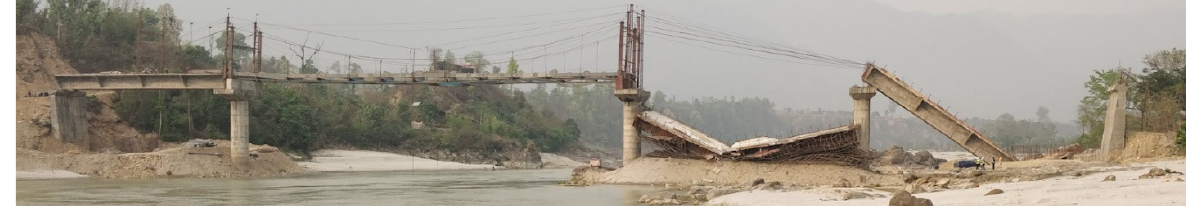
Figure 2. Thimura prestressed bridge with two collapsed